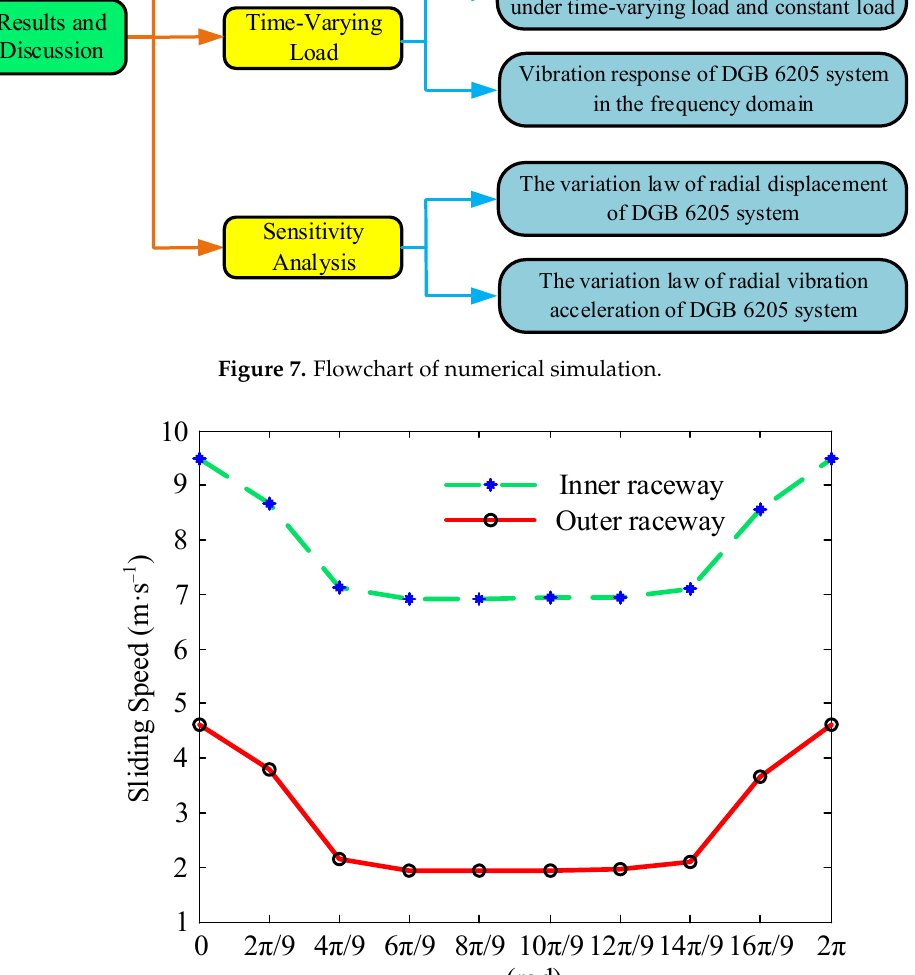
Figure 8. Sliding speed between the ball and the inner raceway and outer raceway.